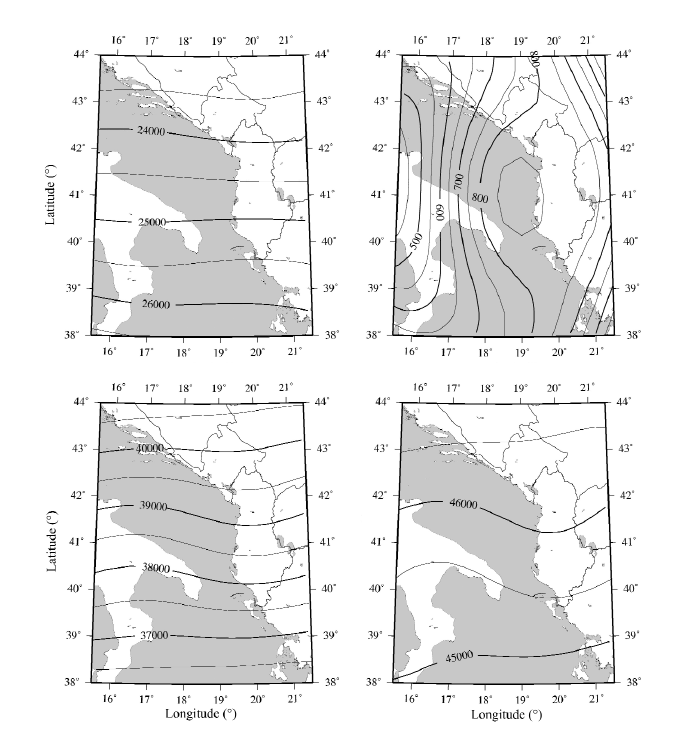
Fig. 2. Maps (in nT) for X (top left), Y (top right), Z (bottom left), and F (bottom right) elements for epoch 1990.0 at sea level obtained from a SCHA model developed on a 3° semiangle cap. Clear large oscillations ap- pear as symptom of lack of the proper spatial spectral